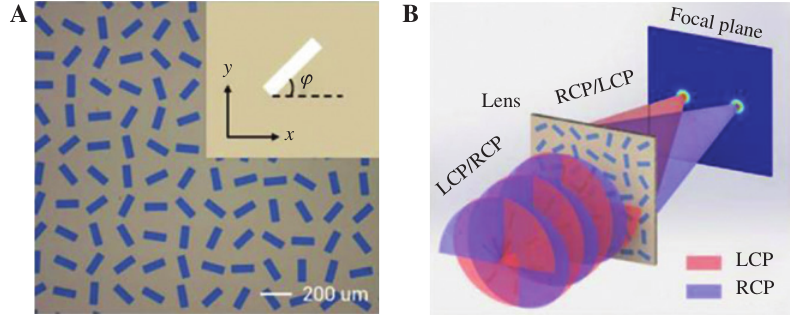
Figure 17: Schematic illustration of the transverse two-foci metasurface lens. (A) The distribution of rectangular silt antennas in metasurface. (B) The metasurface lens focus the incoming beam to two apart spots according to the sense of circular polarization. Adapted from Ref.